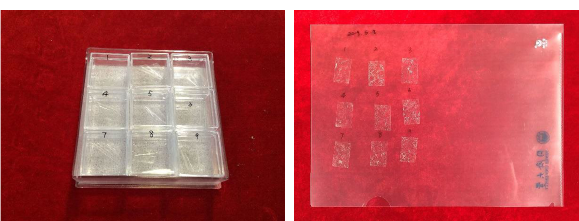
Figure 12 . Conducting the chalking evaluation test on the side of the statue in May 2019. (Source: Tongji-ACL)